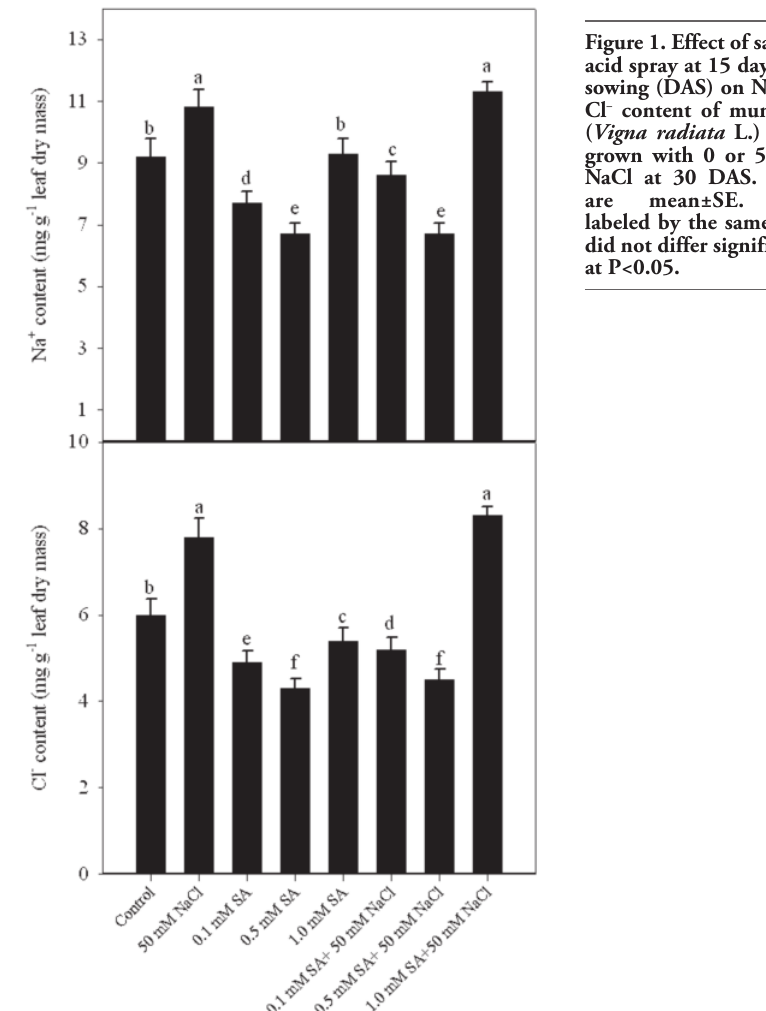
Figure 1. Effect of salicylic acid spray at 15 days after sowing (DAS) on Na + and Cl – content of mungbean ( Vigna radiata L.) plants grown with 0 or 50 mM NaCl at 30 DAS. Values are mean±SE. Data labeled by the same letter did not differ significantly at